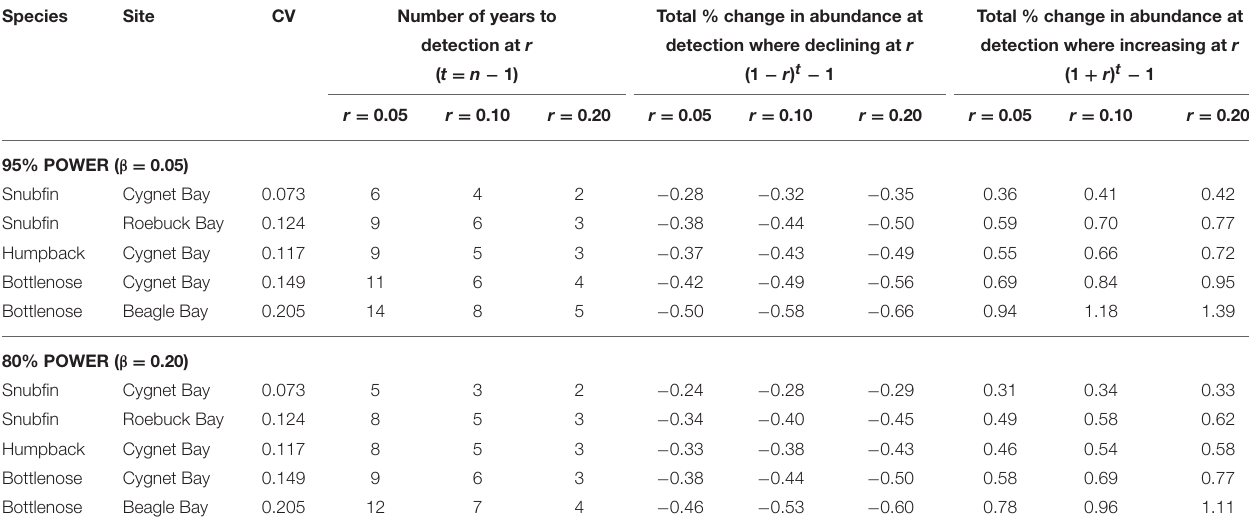
TABLE 5 | Effects of different levels of precision (coefficient of variation, CV) of abundance estimates and statistical power on the number of years to detect different rates of change in abundance, and the corresponding total changes in abundance at the point of detecting changes.